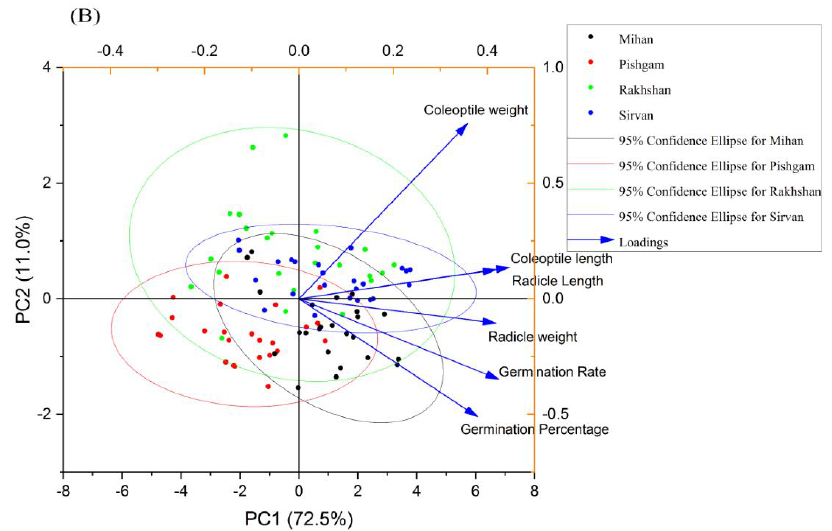
Figure 8. Principal component analysis for the effect of drought stress with three levels of PEG 6000 osmotic potential (−2, −4 MPa and 0 using distilled water as control) on germination and seedling growth of four wheat varieties ( A ), and for the effect of varieties on germination and seedling growth of four wheat varieties ( B